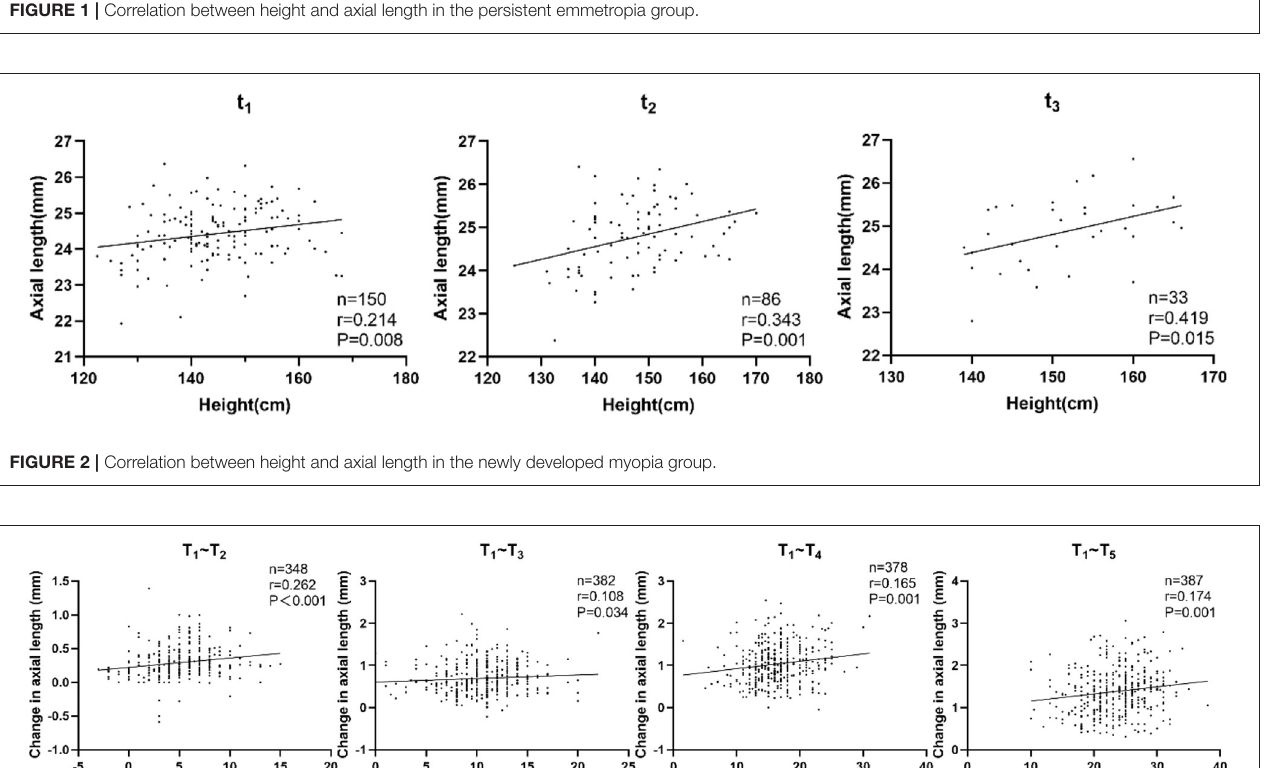
FIGURE 1 | Correlation between height and axial length in the persistent emmetropia group.